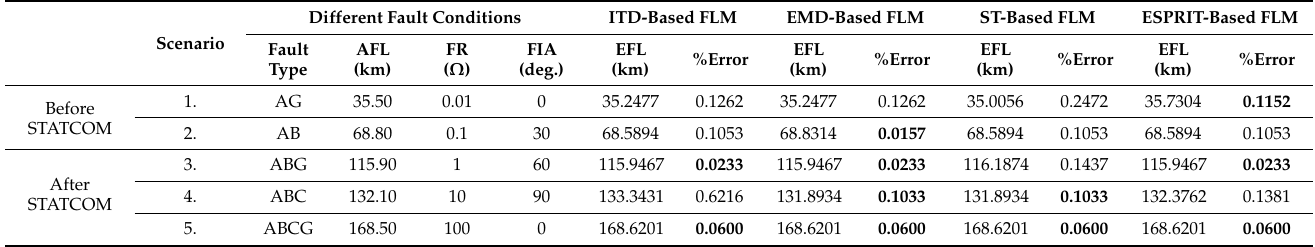
Figure 5. Estimation of ATWs for series-compensated systems for faults after SSSC. ( a – d ) Estimated ATWs for Scenario 3. ( e – h ) Estimated ATWs for Scenario 4. ( i – l ) Estimated ATWs for Scenario 5. Table 2. Performance under shunt compensation (mid-point connected